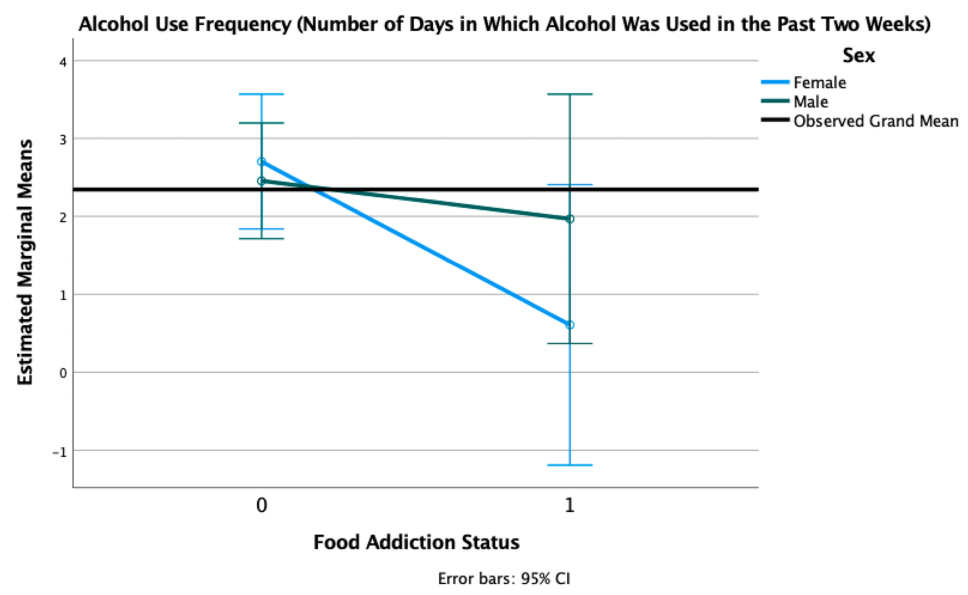
Figure 7. Estimated marginal means of alcohol use frequency for a 2 × 2 factorial ANOVA with sex (female, male) and FA status (1 = positive, 0 = negative, on the X -axis) adjusted for age, race, and PTSD status (threshold vs.